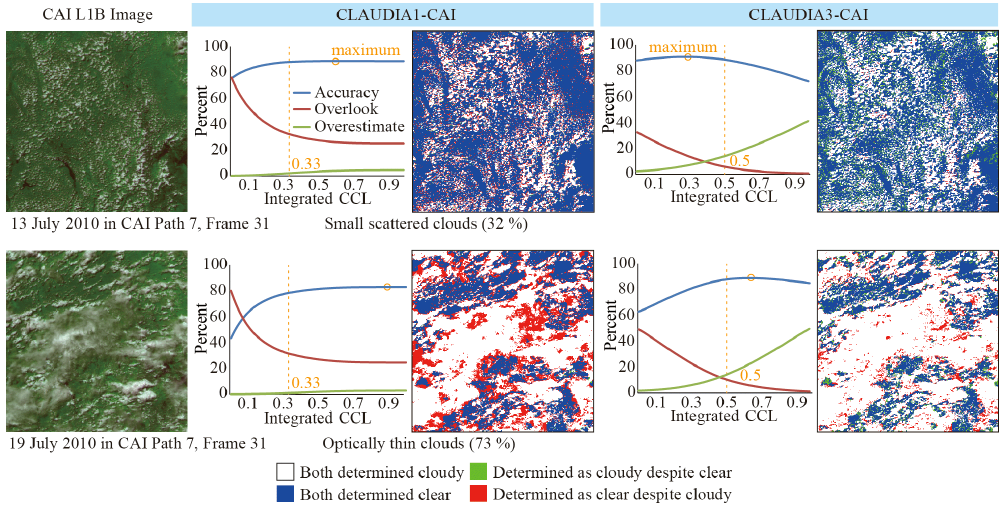
Figure 13. Figure 13 compares the results of the visual inspection images and the output images for two select cases in Borneo: small scattered clouds and optically thin clouds. We used the visual inspection result as the standard image. The comparison of the results for Borneo is similar to that for the Amazon. Figure 14 shows the average accuracy, overlook, and overestimate of all data for all cases in Borneo. These results indicate that the most suitable integrated-CCL thresholds are 0.85 for the CLAUDIA1–CAI and 0.35 for CLAUDIA3– CAI in Borneo. Since the curved lines of the overestimate and overlook intersect in the same way as the Amazon cases, CLAUDIA3–CAI can appropriately determine the boundary between cloudy and clear sky.